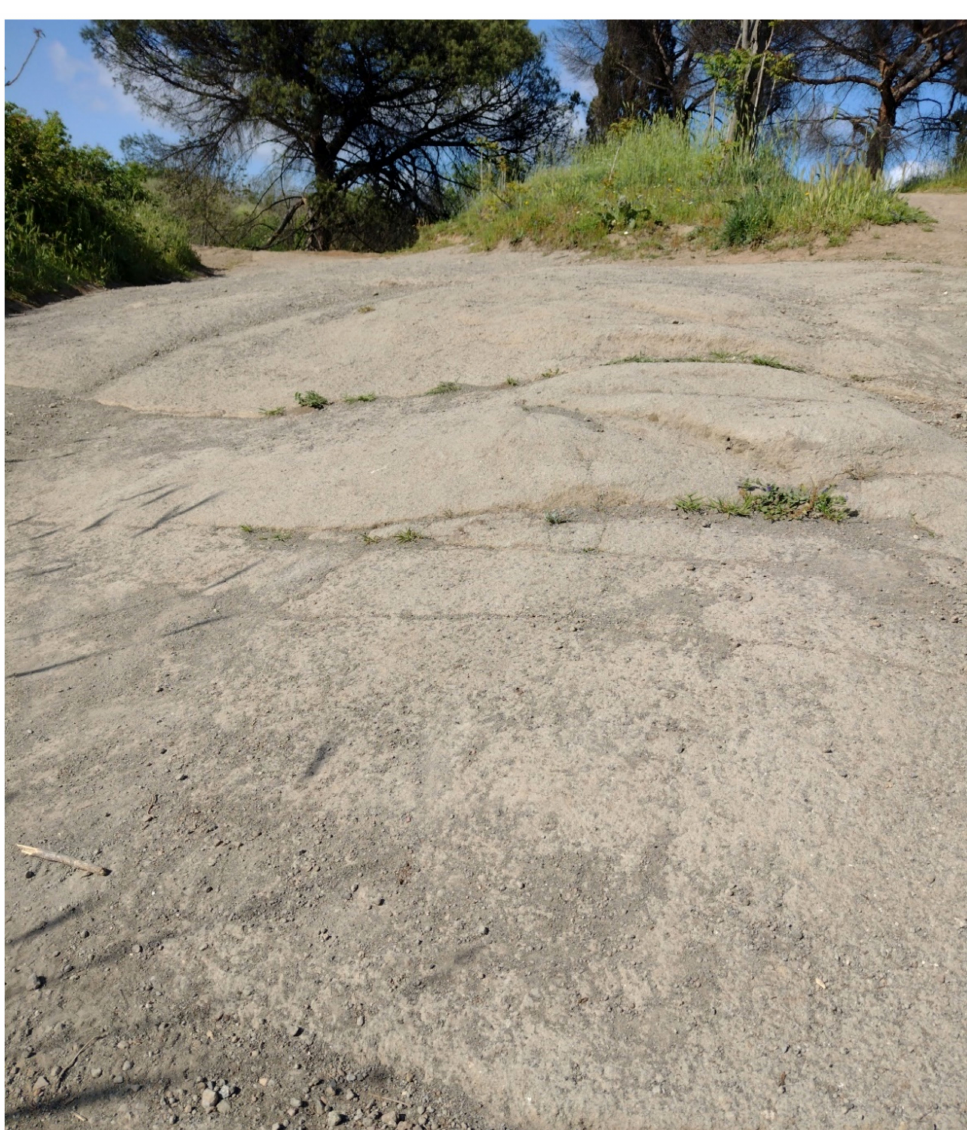
Figure 2. Lava Colata di Capo di Bove (south of Caffarella valley, north of the